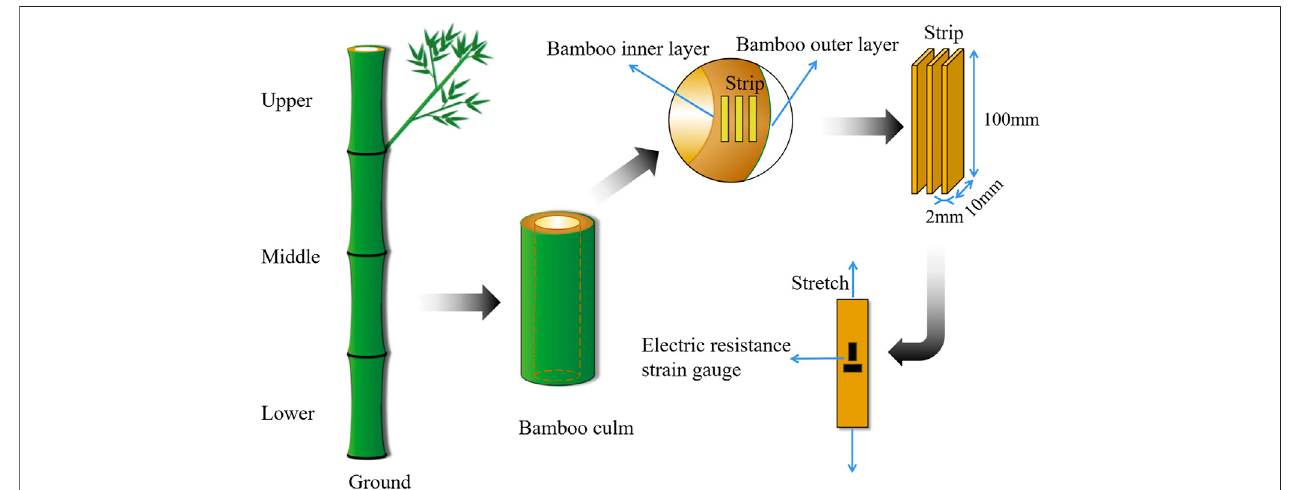
FIGURE 1 | The schematic illustration of the process for the preparation of bamboo for Poisson ’ s ratio test.